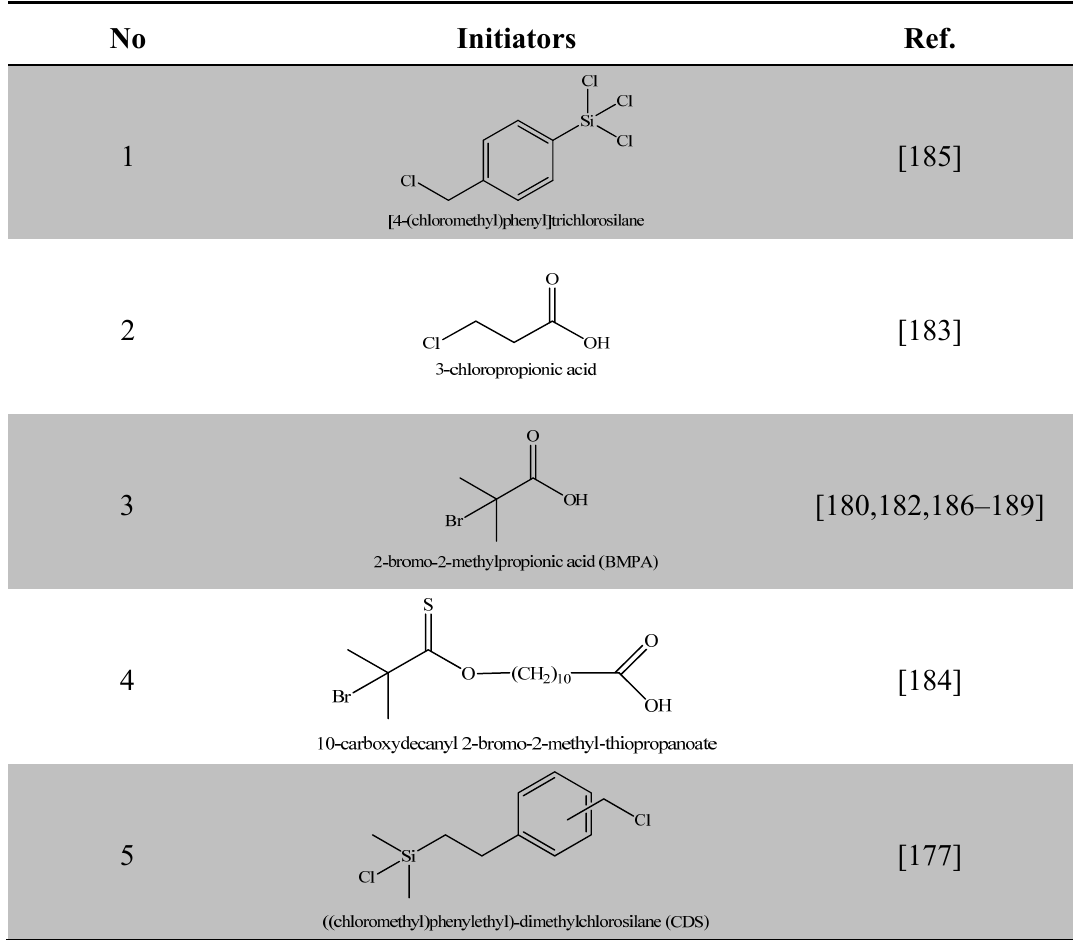
Table 5. ATRP initiators anchored on the surface of magnetic